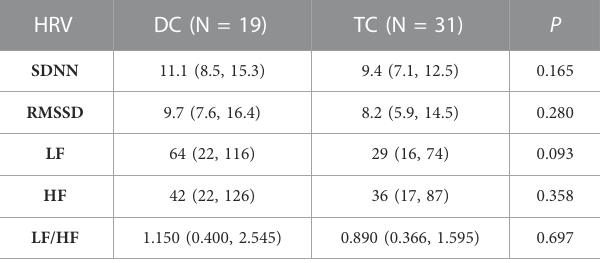
TABLE 2 HRV parameters of the patients before